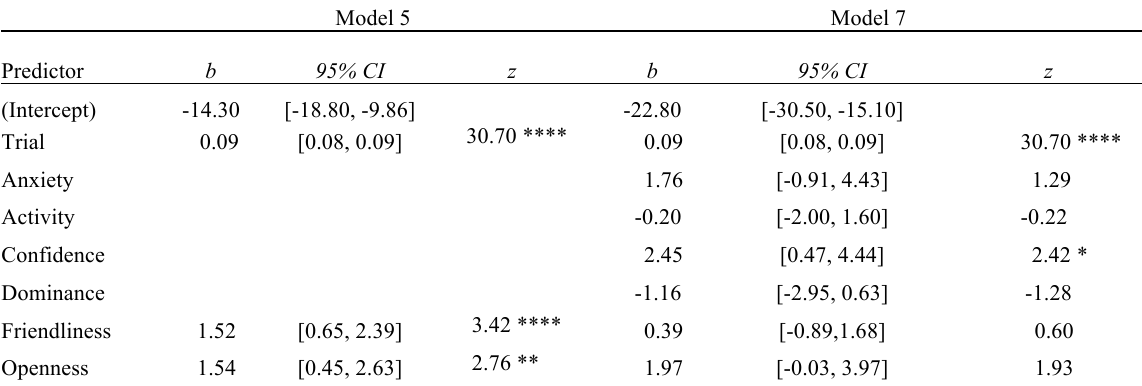
Details of Binomial Regression Models of Interest, Predicting Rewarded Trials from Personality